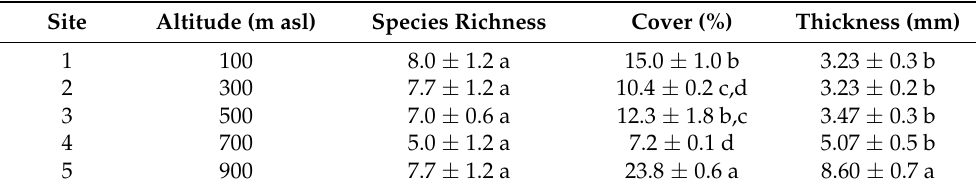
Table 2. One-way ANOVA showing the composition and distribution of terrestrial mosses along the elevation gradient ( n = 3). Site Altitude (m asl)